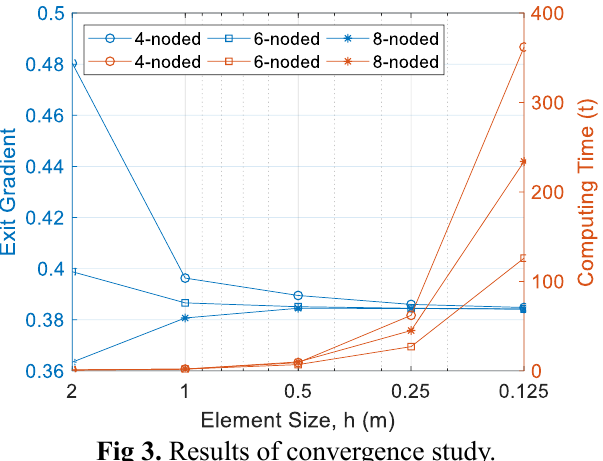
Fig 3. Results of convergence